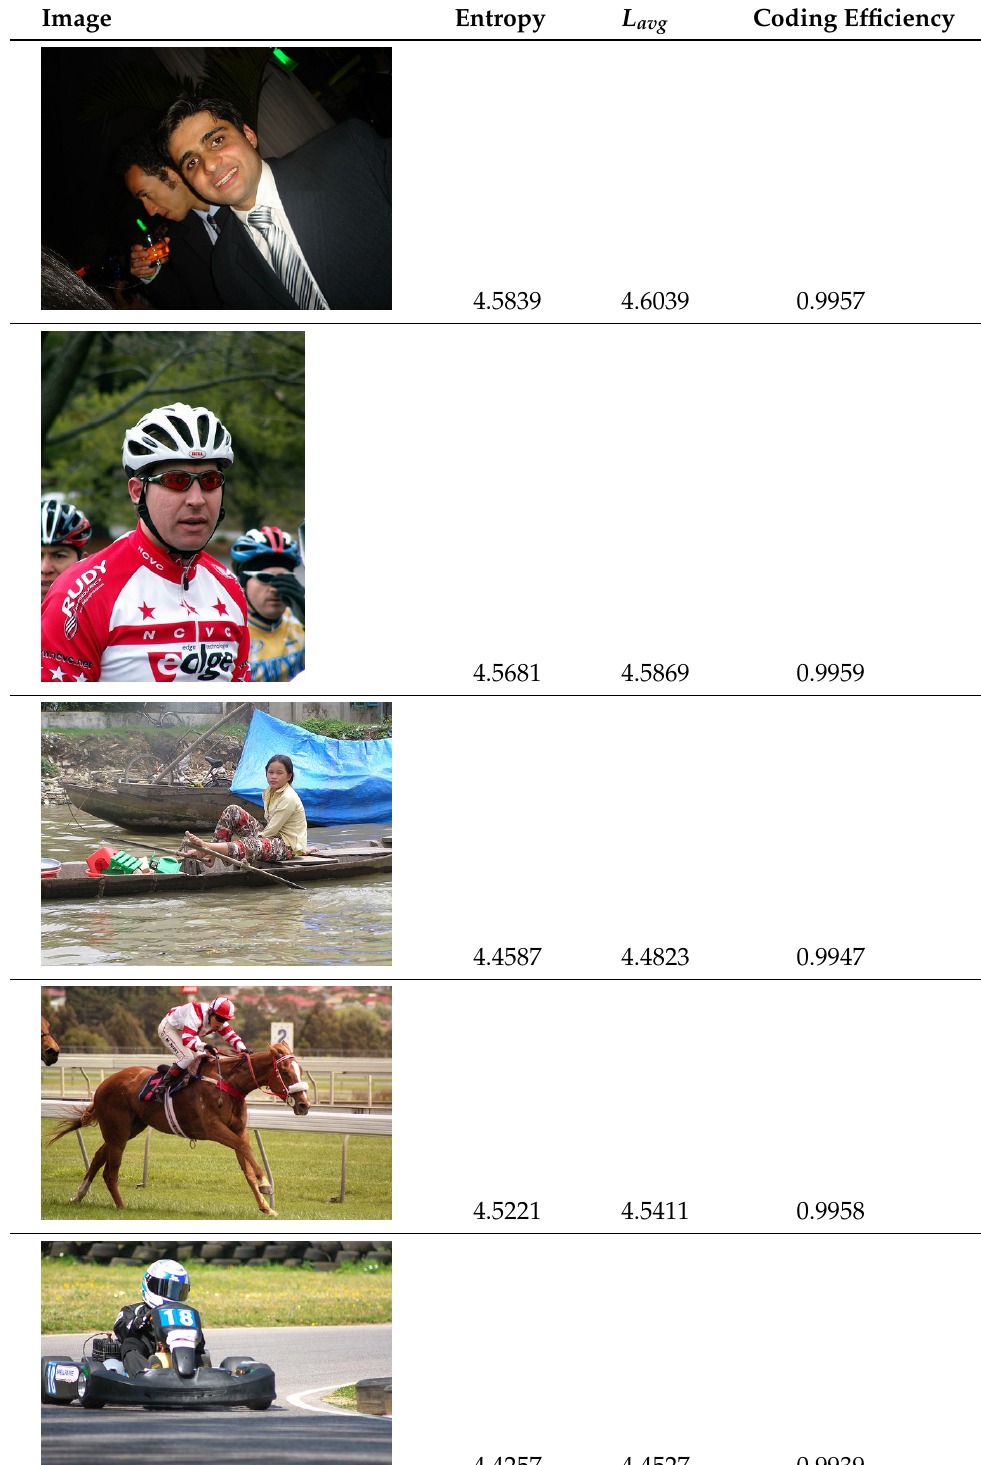
Table 4. The Huffman coding